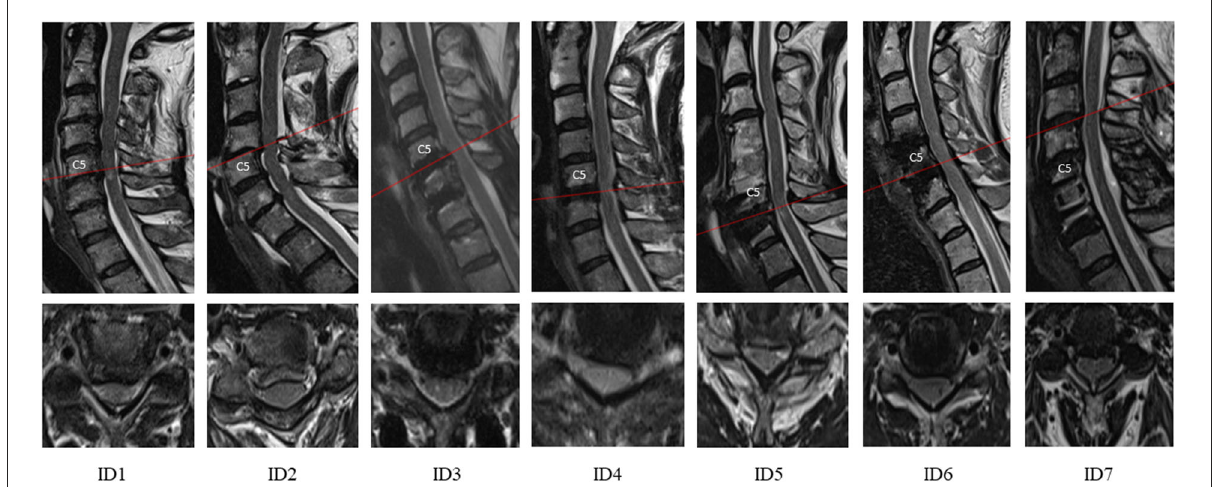
FIGURE2 Sagittal and axial cervical MRI from the time of consultation shown for all subjects (ID1-7). The red line indicates the level of maximum stenosis. Spine imaging shows that all patients had spinal canal stenosis; T2-hyperintensity was present in 5 out of 7. Structural changes from previous spine surgery can be seen (ID3-7, e.g., anterior decompression with fusion in ID7).